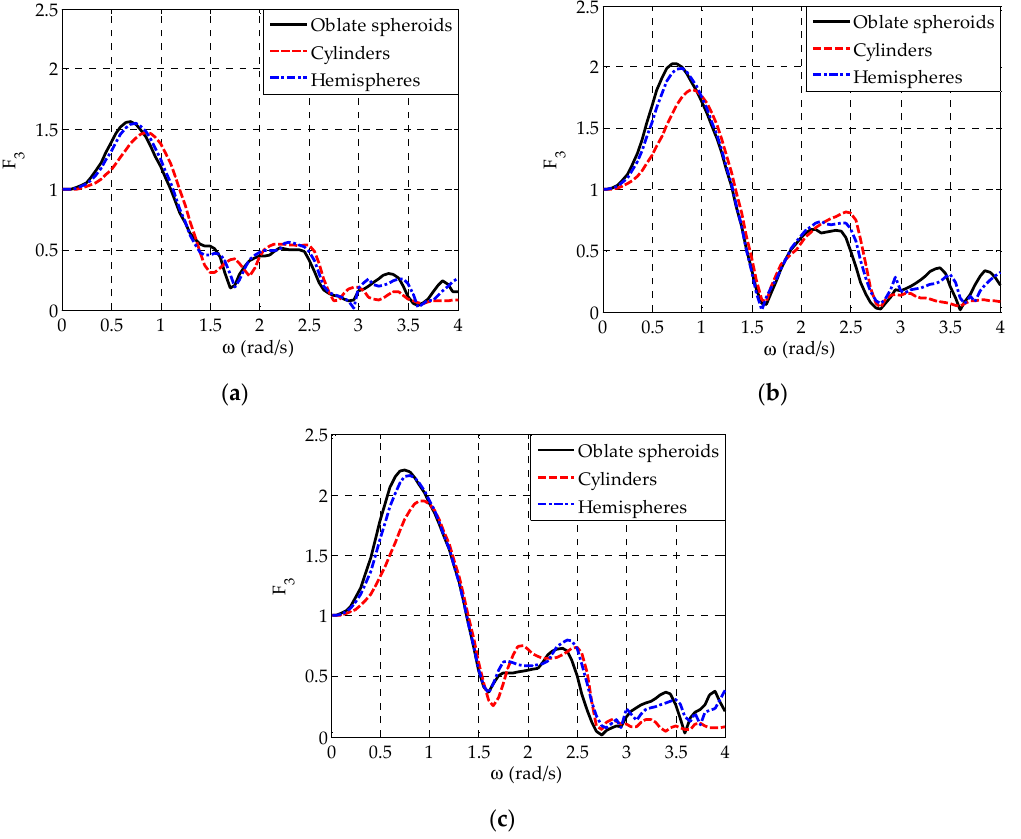
Figure 4. Comparison of F 3 for arrays with di ff erent WEC geometries and for l w / a = 18, c = 6 m, l bet / a = 4: ( a ) WEC1 and WEC5, ( b ) WEC2 and WEC4, and ( c ) WEC3.